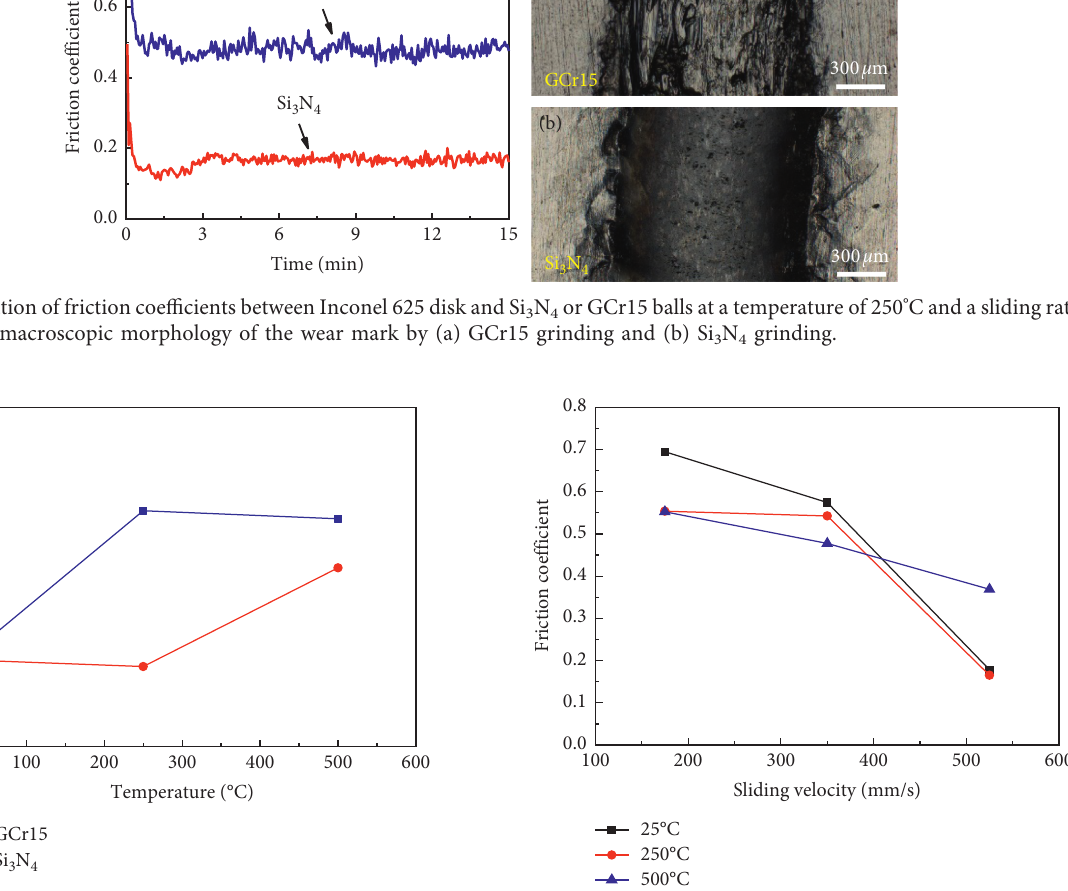
Figure 5: Effects of sliding speeds on the friction coefficient of Si 3 N 4 against Inconel 625 under a load of 15N at different